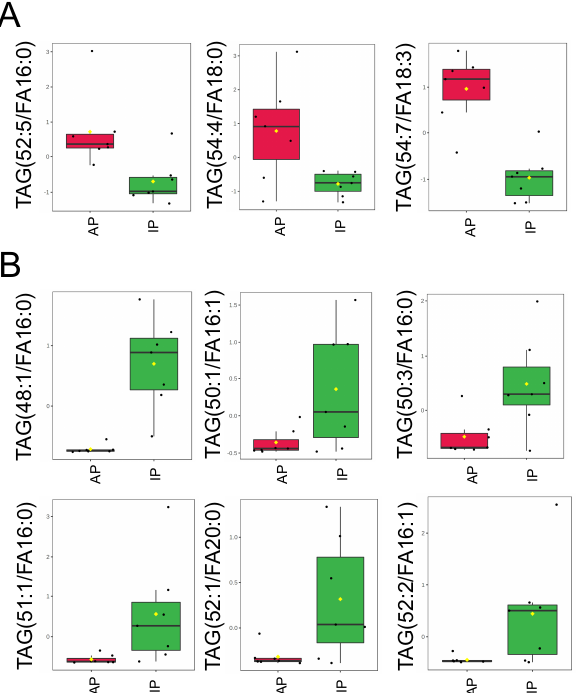
Figure 5. Triacylglycerol levels in uEVs isolated from urine collected during the inactive and active phases of spontaneously hypertensive aged male mice. ( A ). Normalized plots showing 3 TAGs that are significantly increased in EVs isolated from urine samples collected during the active phase (AP) compared to the inactive phase (IP). ( B ). Normalized plots showing 6 TAGs that are significantly decreased in EVs from the AP group compared to the IP group. Data were normalized to the median with Pareto scaling and the plots were made in MetaboAnalyst software. n = 7 samples per group. EVs isolated from AP urine are in red and EVs isolated from IP urine are in green. The concentration of each lipid on the y -axis is given in µ M.